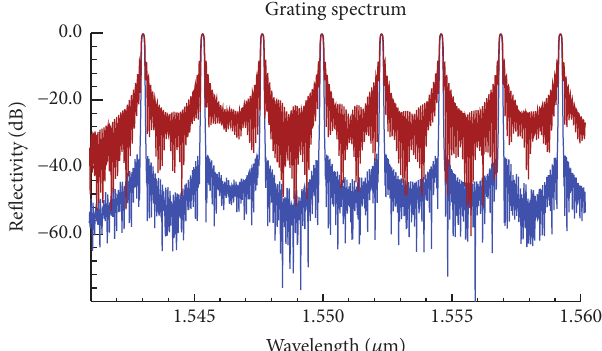
Figure14:The8FBGstrainsensorswith2 nmspacing:red:uniform and blue: optimized.